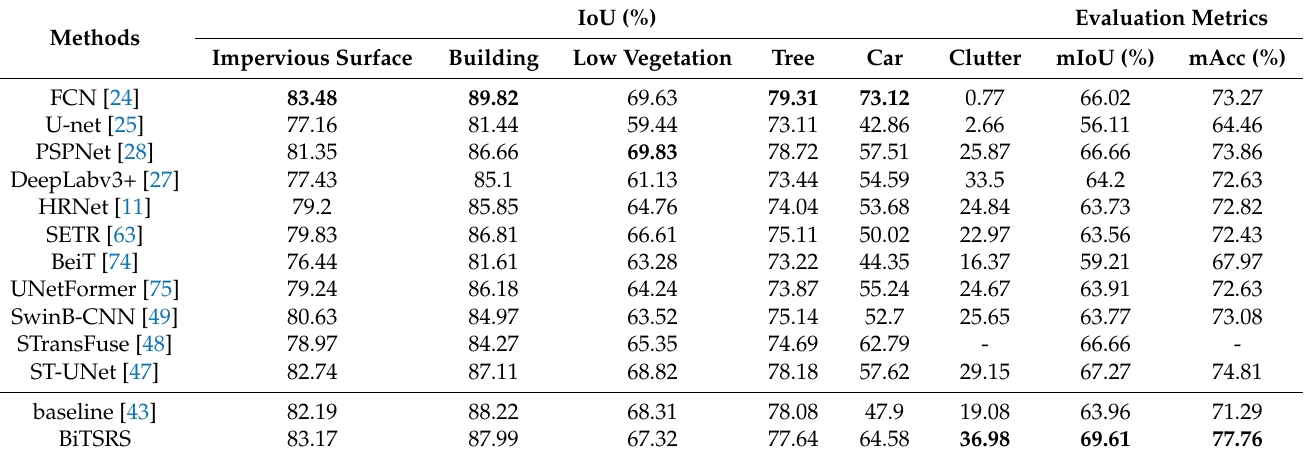
Table 4. Comparison with some state-of-the-art methods on the ISPRS Vaihingen dataset. The maximum value of each column is shown in